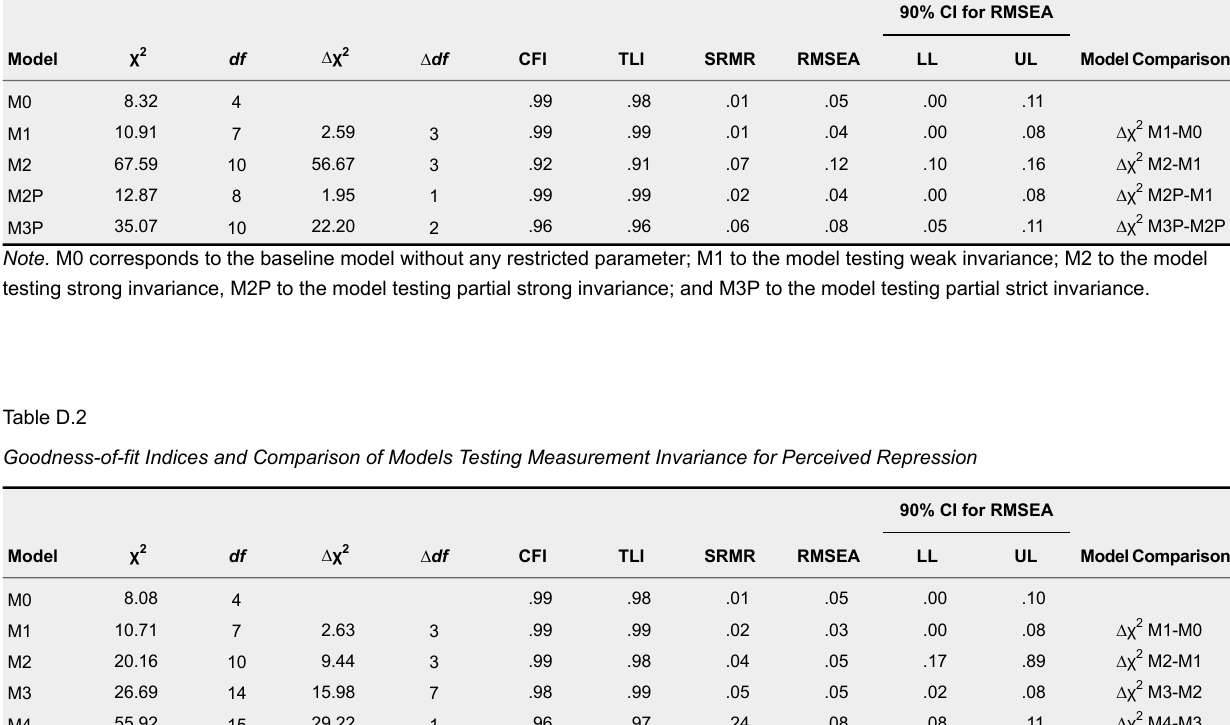
ModelComparison90% CI for RMSEA